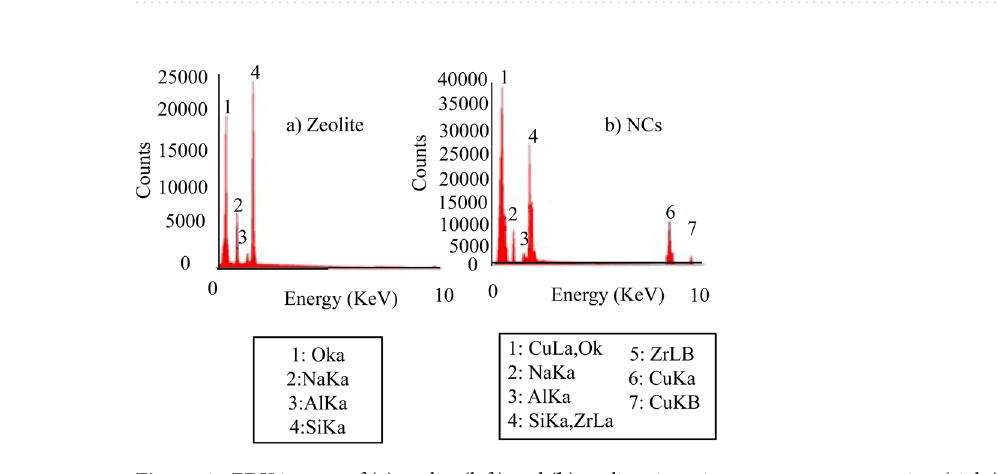
Figure 6. EDX images of ( a ) zeolite (left) and ( b ) zeolite-zirconia ‑ copper nanocomposites (right).